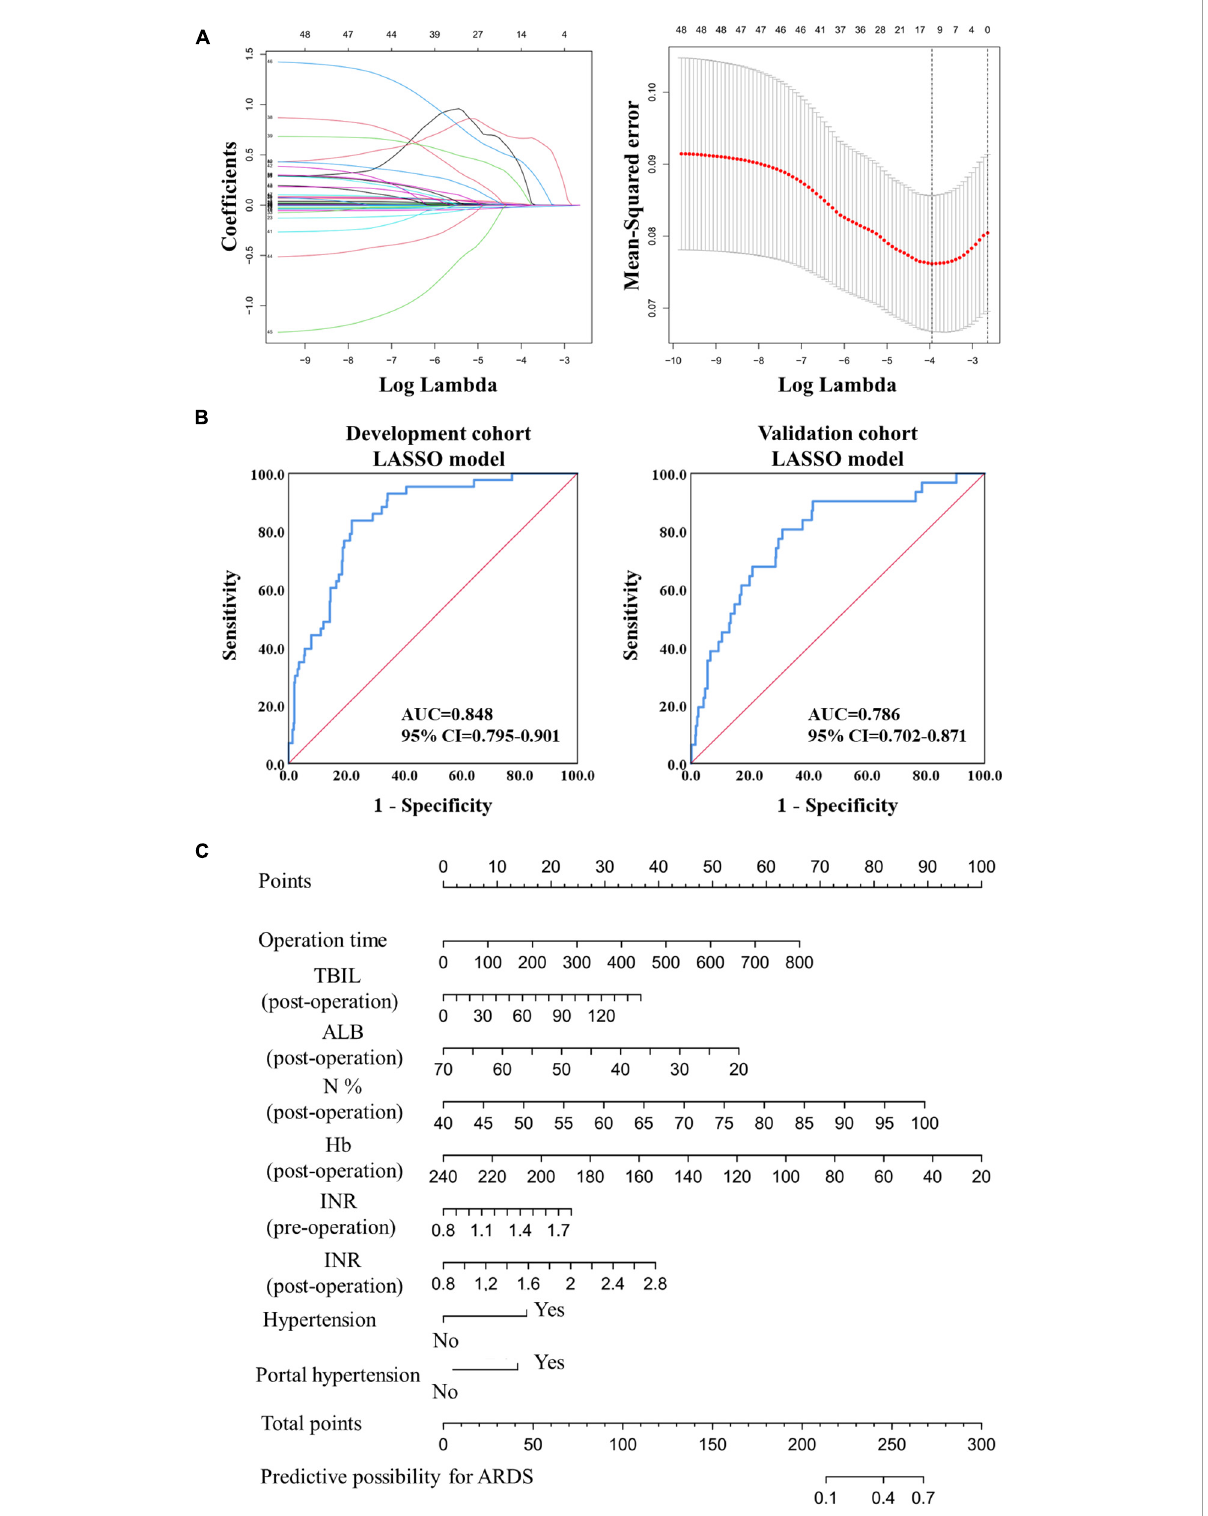
FIGURE2 Model construction and validation based on LASSO regression. (A) The construction of prediction model based on the LASSO regression. (B) The ROC analysis of the prediction model in the development and validation cohorts. (C) The nomogram of the prediction model based on the LASSO regression in the development